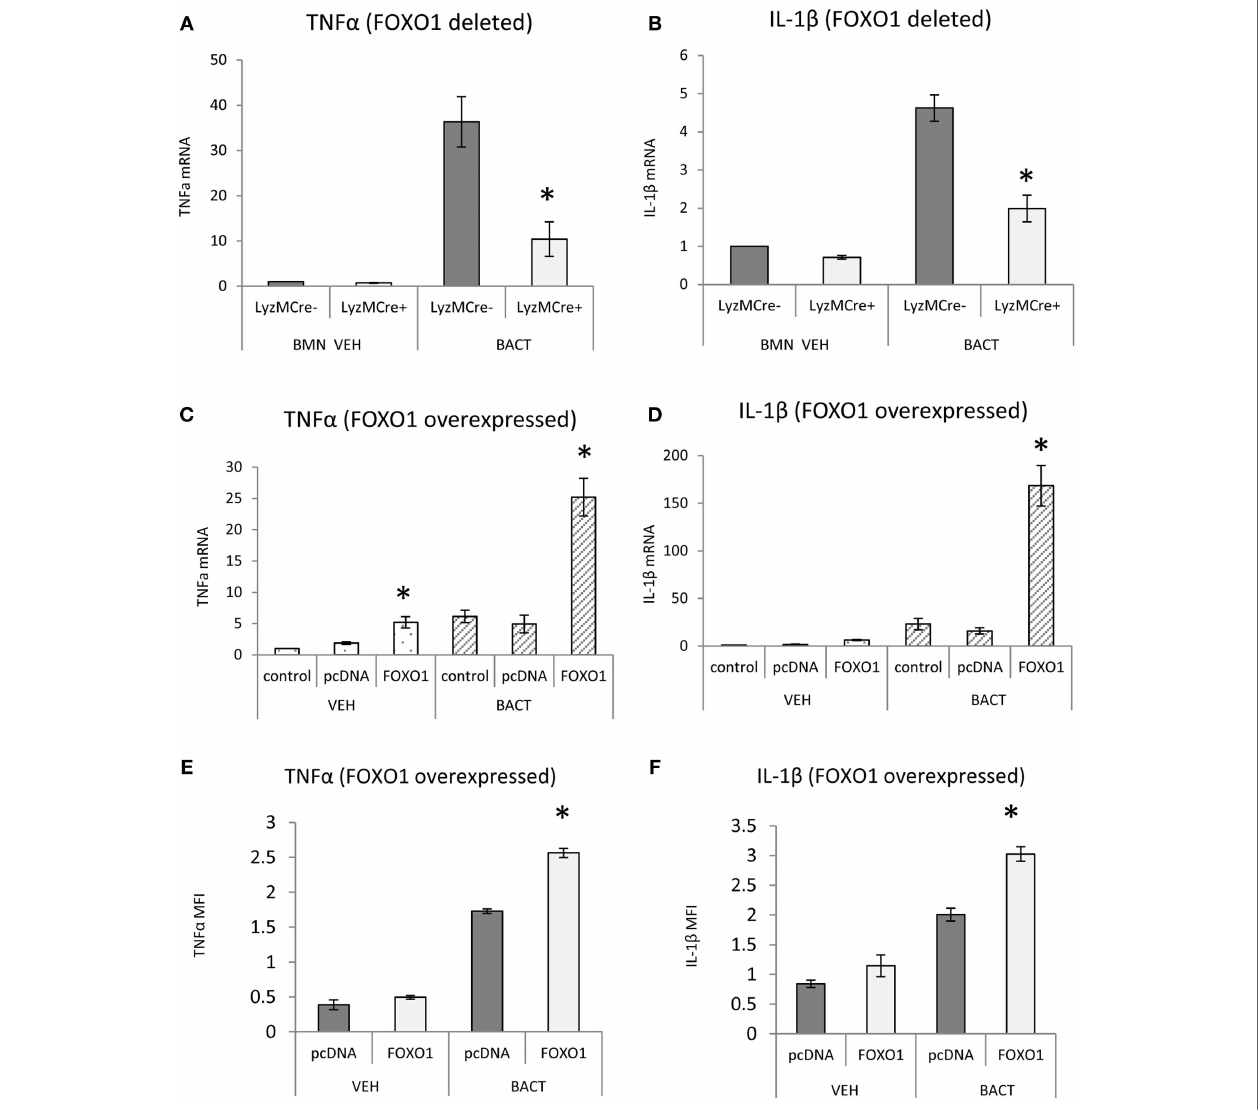
FigUre 7 | FOXO1 regulates TNF α and IL-1 β . (a,B) Neutrophils from FOXO1-deleted LyzM.Cre + FOXO1 L/L mice and littermate control LyzM.Cre − FOXO1 L/L mice were incubated with Porphyromonas gingivalis . RNA was isolated from neutrophils and mRNA levels of TNF α or IL-1 β were measured by RT-PCR and normalized to ribosomal protein L32. (c–F) HL-60 neutrophils were transfected with FOXO1 or empty vector alone and stimulated with bacteria or vehicle. (c,D) RNA was isolated from neutrophils and mRNA levels of TNF α and IL-1 β measured by real-time PCR. (e,F) Cells were incubated with anti-TNF α or anti-IL-1 β antibody (sc-7884,